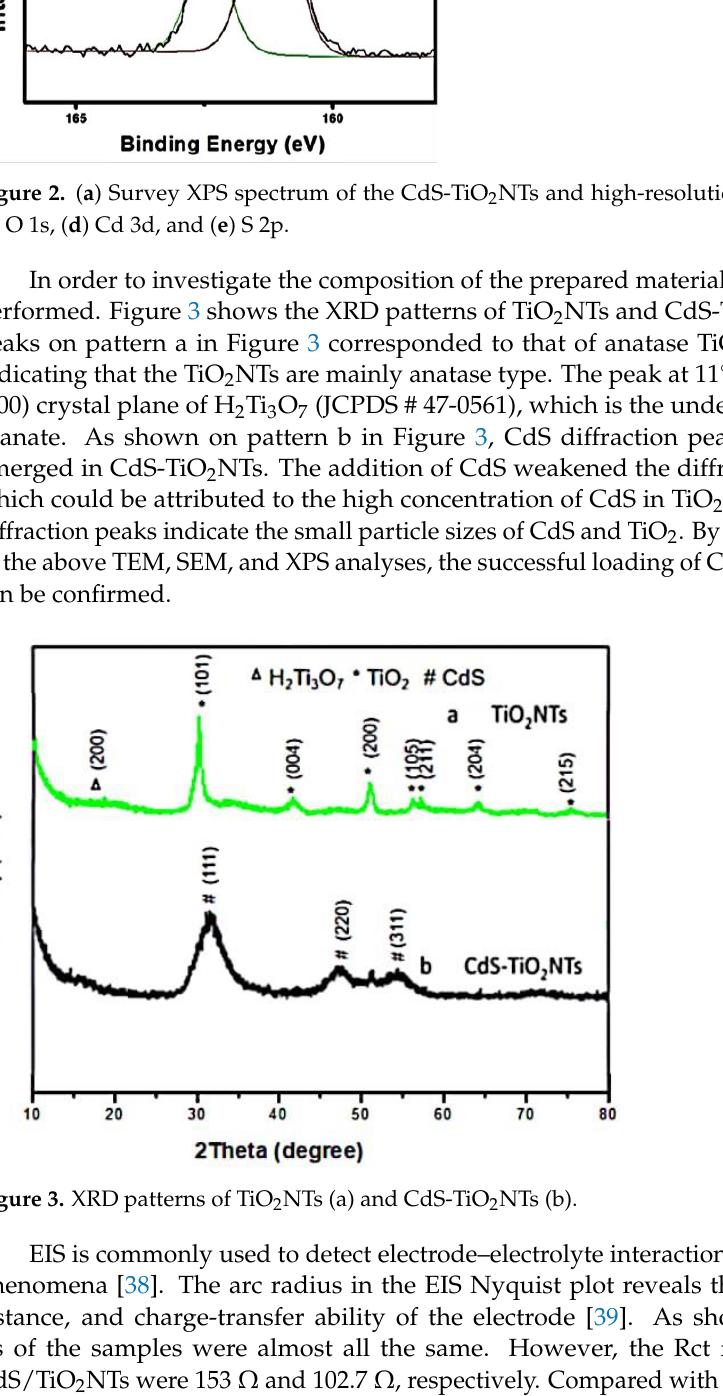
Figure 4. EIS of TiO 2 and CdS/TiO 2 NTs.